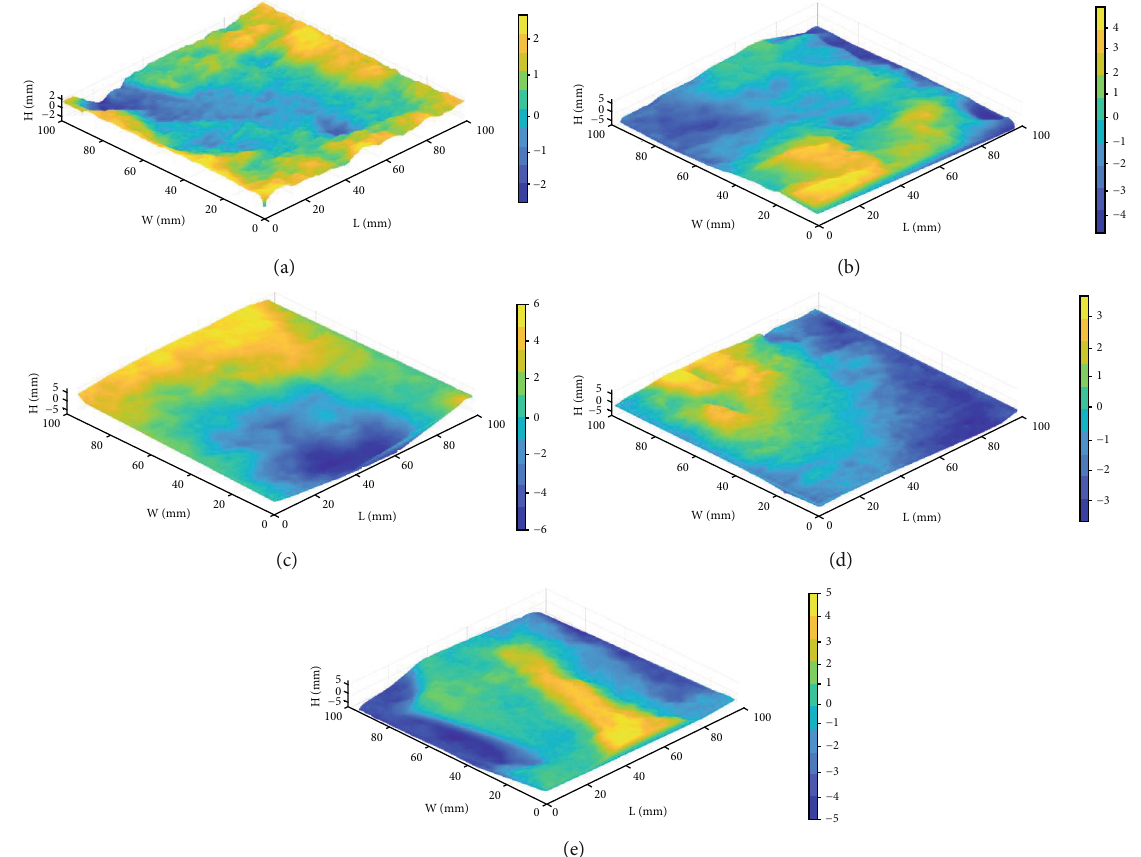
Figure 6: Initial 3D Morphology of Discontinuities. (a) p-1. (b) p-2. (c) p-3. (d) p-4. (e)